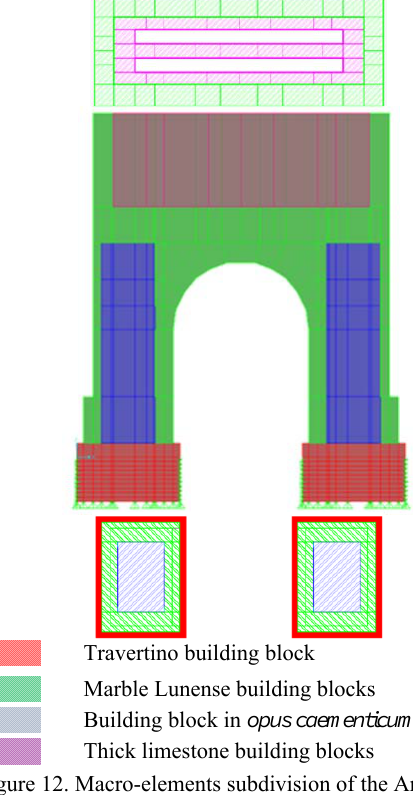
Figure 12. Macro-elements subdivision of the Arch, with breakdown by material